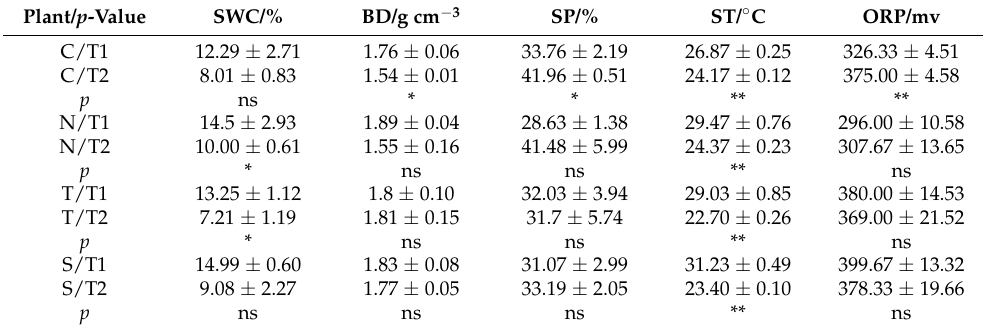
Table 1. The contents of soil physical properties under different emergence phases (T1 for early phase and T2 for late phase) within the Three Gorges Dam Reservoir, China. The values of soil water content (SWC), bulk density (BD), soil temperature (ST), oxidation-reduction potential (ORP), and soil porosity (SP) measure in bulk soil for selected plants. Plant/ p -Value SWC/% BD/g cm − 3 SP/% ST/ ◦